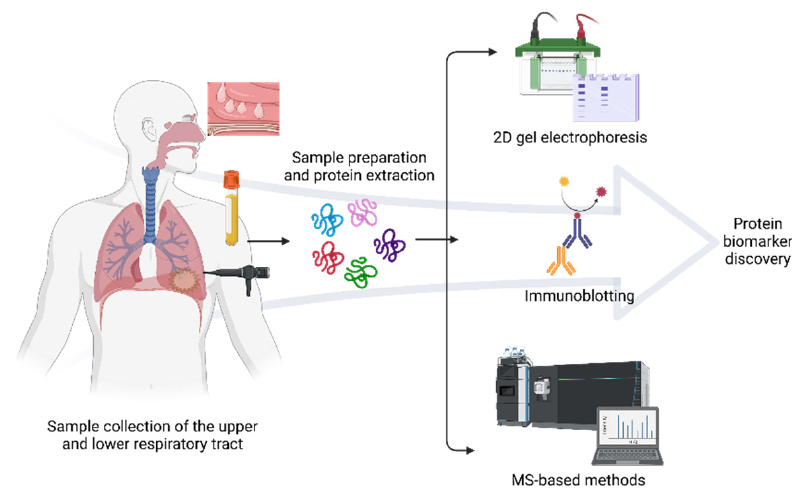
Figure 1. General proteomics workflow in respiratory allergy. Protein analysis of several biological samples such as serum, blood cells, NLF, BAL, NP, sputum, and saliva may reflect how the pro- teome varies in allergic diseases. The predominant methods for discovering protein biomarkers of allergy include 2D gel electrophoresis combined with immunochemical detection and subsequent identification by mass spectrometry. Created with BioRender.com (accessed on 10 May 2022).